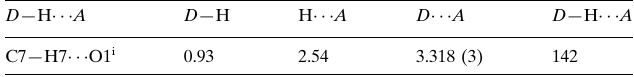
Hydrogen-bond geometry (A˚ , (cid:2)